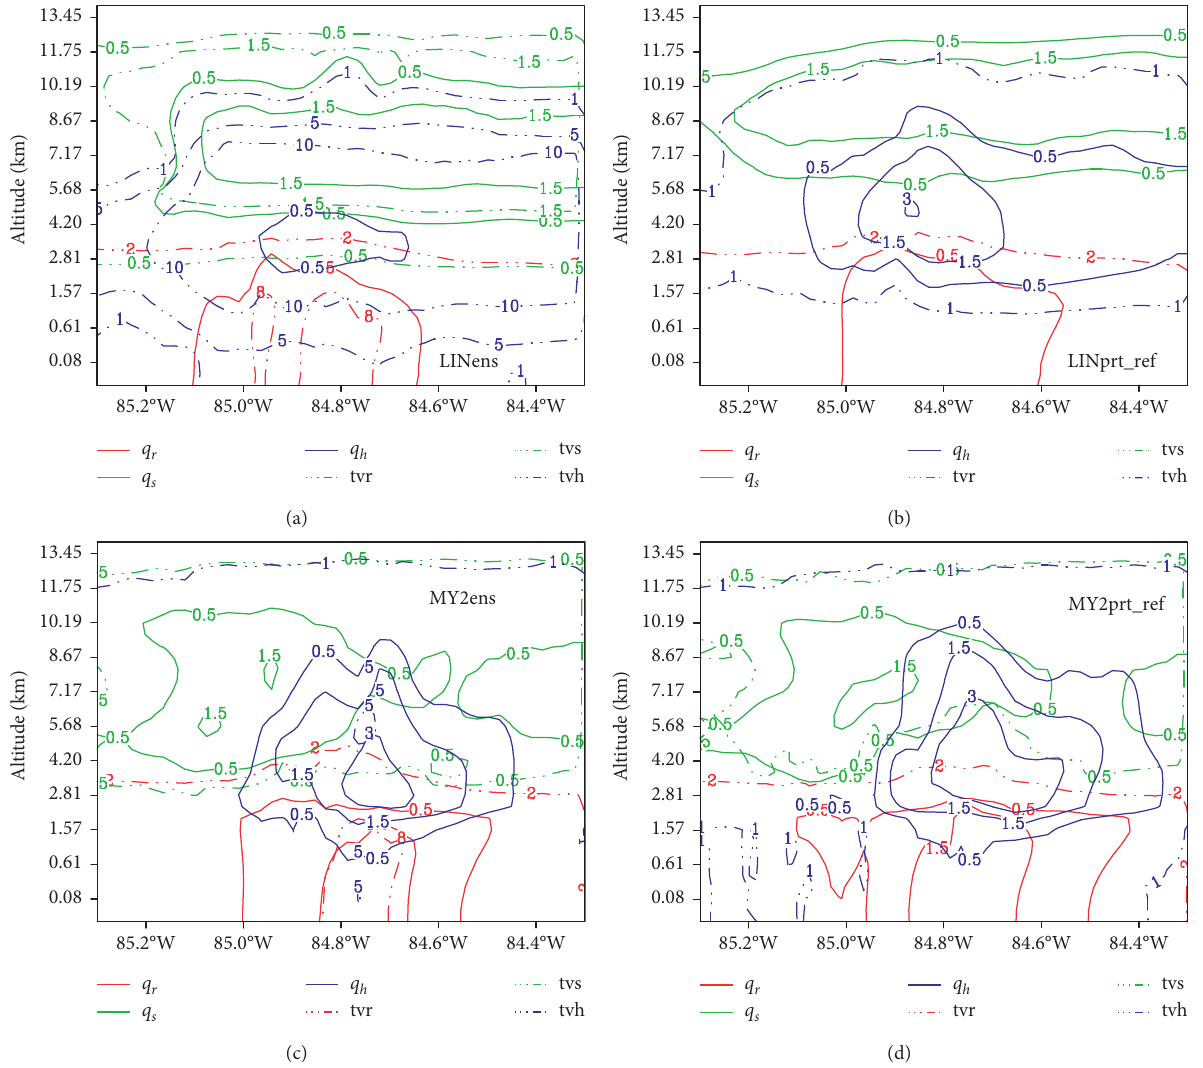
Figure 8: Vertical cross-sections of q · kg − 1 ), q · kg − 1 ), qh (blue solid, g · kg − 1 ), and their corresponding terminal r (red solid, g s (green solid, g velocities (dot-dashed, m · s − 1 ) at 0230 ZUTC along 34.4 ° N for (a) LINens, (b) LINprt_ref, (c) MY2ens, and (d) MY2prt_ref. Values shown in this figure are the meridional averages between 34.2 ° N and 34.6 °